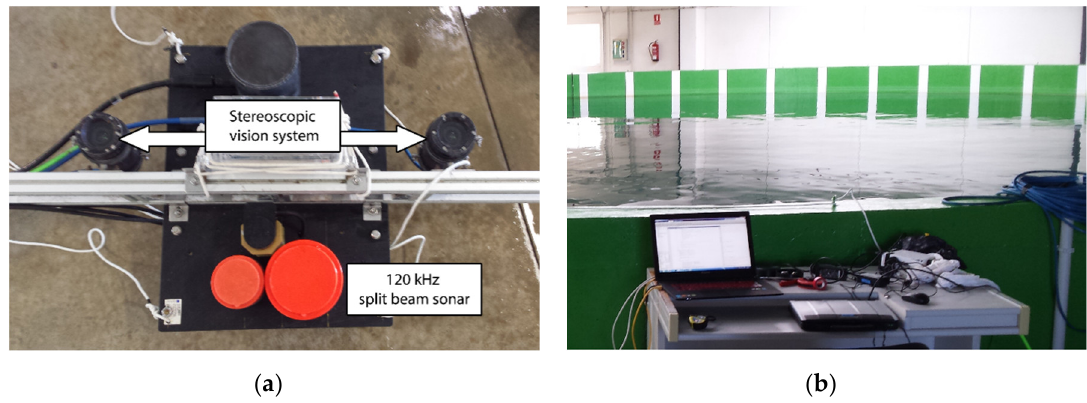
Figure 2. ( a ) Sensor platform equipped with a stereoscopic camera and a 120 kHz split beam sonar, among other sensors, ( b ) Logging computer placed close to the tanks to register the recordings.